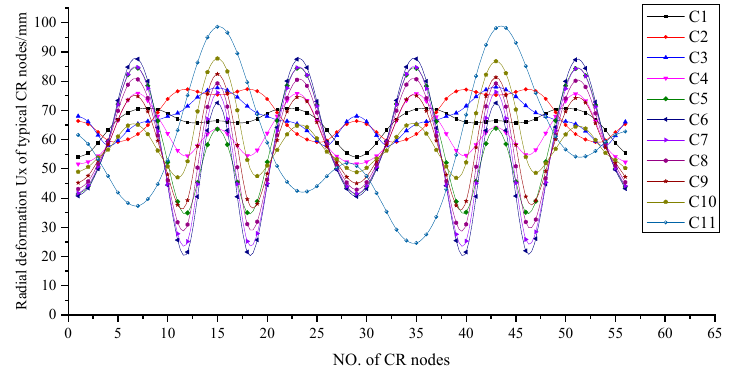
Figure 25. Radial deformation Ux of CR nodes under local coordinate system.